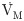
Correlation of HVR and HCVR values (V˙M) in HK483 mice.The values of HRV measured at -2, -1, 1, 2, and 3 days after intranasal inoculation were plotted against those of HCVR at the same times. n = 15 HK483 mice for each day (total 5 days, 75 data points). The significant correlation suggests that a poor HVR is often associated with an inadequate HCVR in HK483 mice.